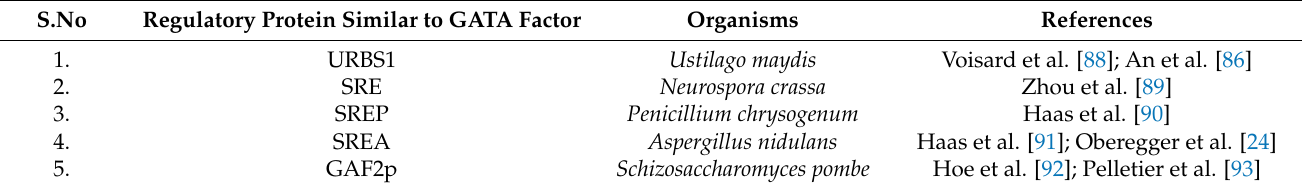
Figure 4. Regulatory model of biosynthesis of siderophore and Fur Box activation or repression: At the high iron concentration, formation of Fur box protein and iron complex in the promoter region of the DNA and RNA polymerases are unable to move forward due to the regression of the gene, while at low concentration of iron, Fur proteins release RNA polymerases leading to the expression of genes. Table 3. Negative fungal regulatory proteins in the biosynthesis and transport of siderophores.